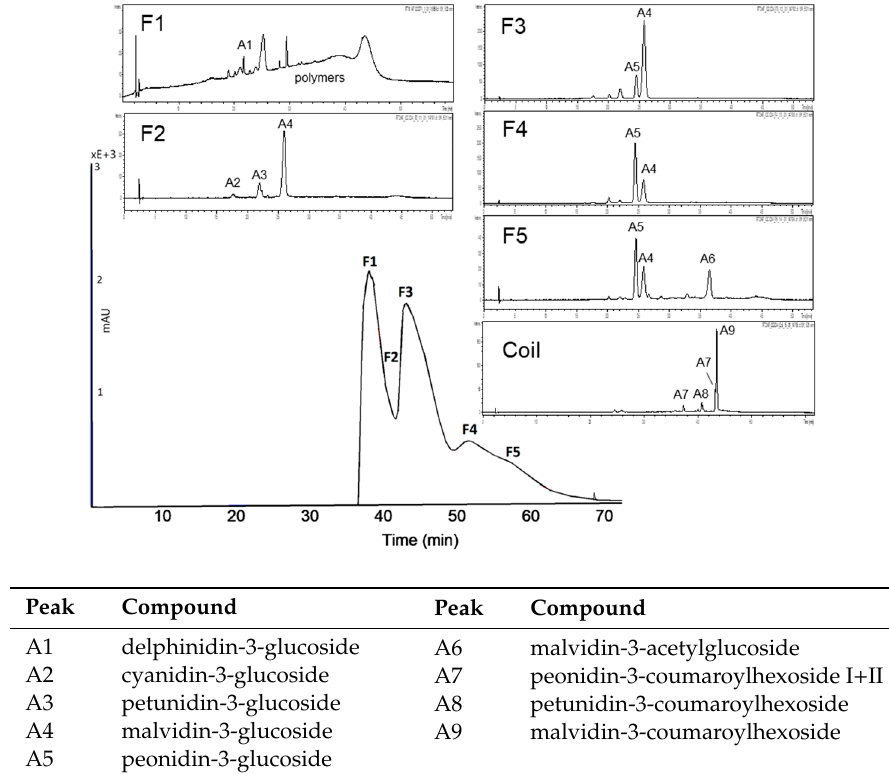
Figure 4. High-performance countercurrent chromatography (HPCCC) chromatogram at a wavelength of λ 520 nm of the anthocyanin fraction of the red grape juice concentrate (JC) sample and HPLC-ESI-MS chromatograms indicating the composition of each fraction.